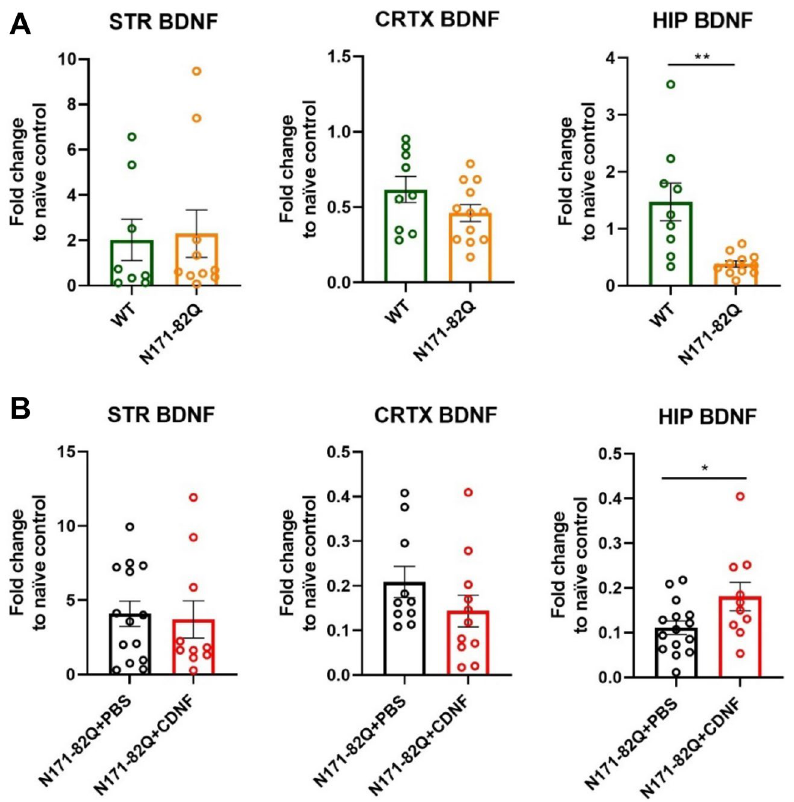
Figure 9. mRNA level of BDNF in the striatum, cortex and hippocampus. ( A ) mRNA expression of BDNF in total lysates of striatum, cortex and hippocampus; results are presented as a fold change compared to naïve control. ** p < 0.005, unpaired t-test. Values are the means ± SEMs. N per group = 8–11. ( B ) qPCR for BDNF mRNA in the striatal, cortical and hippocampal extracts of N171-82Q mice chronically treated with CDNF or PBS. Results are presented as a fold change compared to naïve control. * p < 0.05, unpaired t-test. Values are the means ± SEMs. N per group = 10–15.